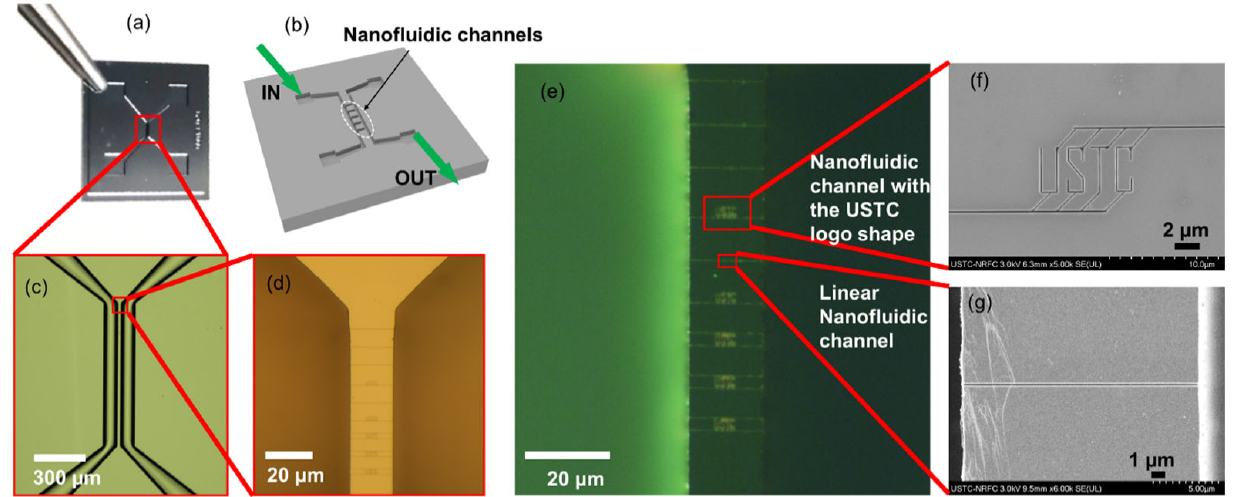
Figure 6. ( a ) Photograph of the fabricated micro ‐ nanofluidic channel device. ( b ) 3D cartoon image illustrating the micro ‐ nanofluidic device. ( c , d ) Bright ‐ field optical microscopic photographs of the micro ‐ nanofluidic channels. ( e ) Fluorescence microscopic image showing the fluorescence flowing from the left ‐ side microchannel to the right ‐ side microchannel through the nanofluidic channels, confirming the functionality. ( f ) SEM image of a customized nanofluidic channel with the USTC logo shape. ( g ) SEM image of a linear nanofluidic channel.